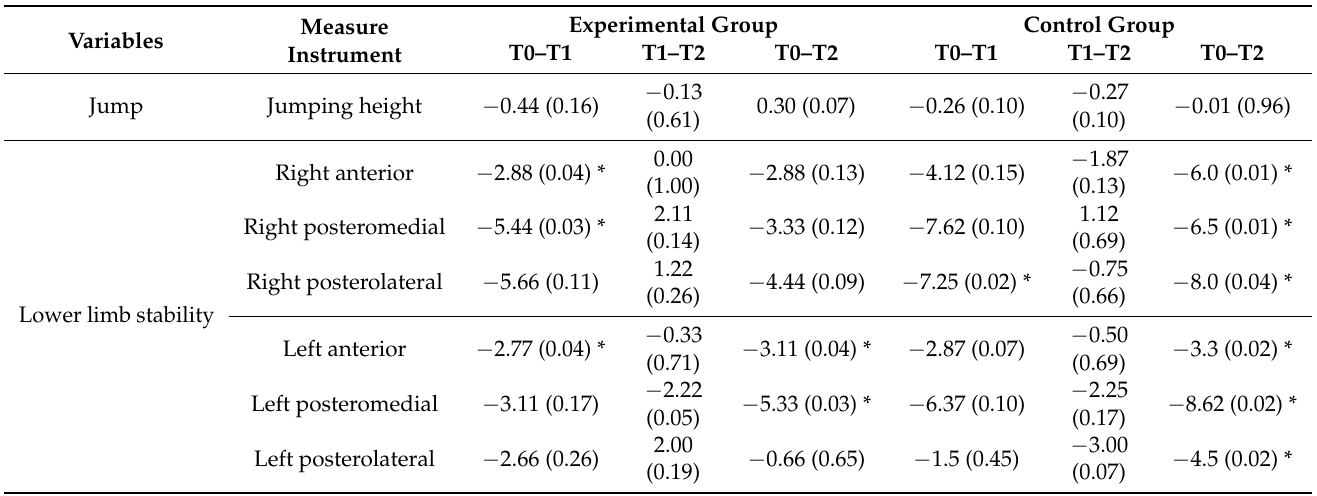
Table 3. Statistical analysis of the difference in means (and statistical significance) of the study variables between the baseline and post-treatment, and baseline and follow-up